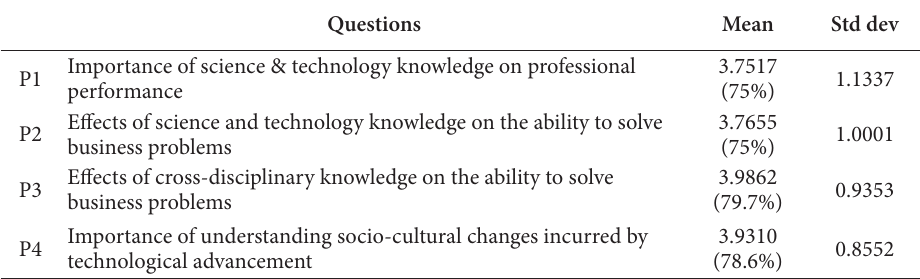
Table 3. Effects of cross-disciplinary knowledge of business operations